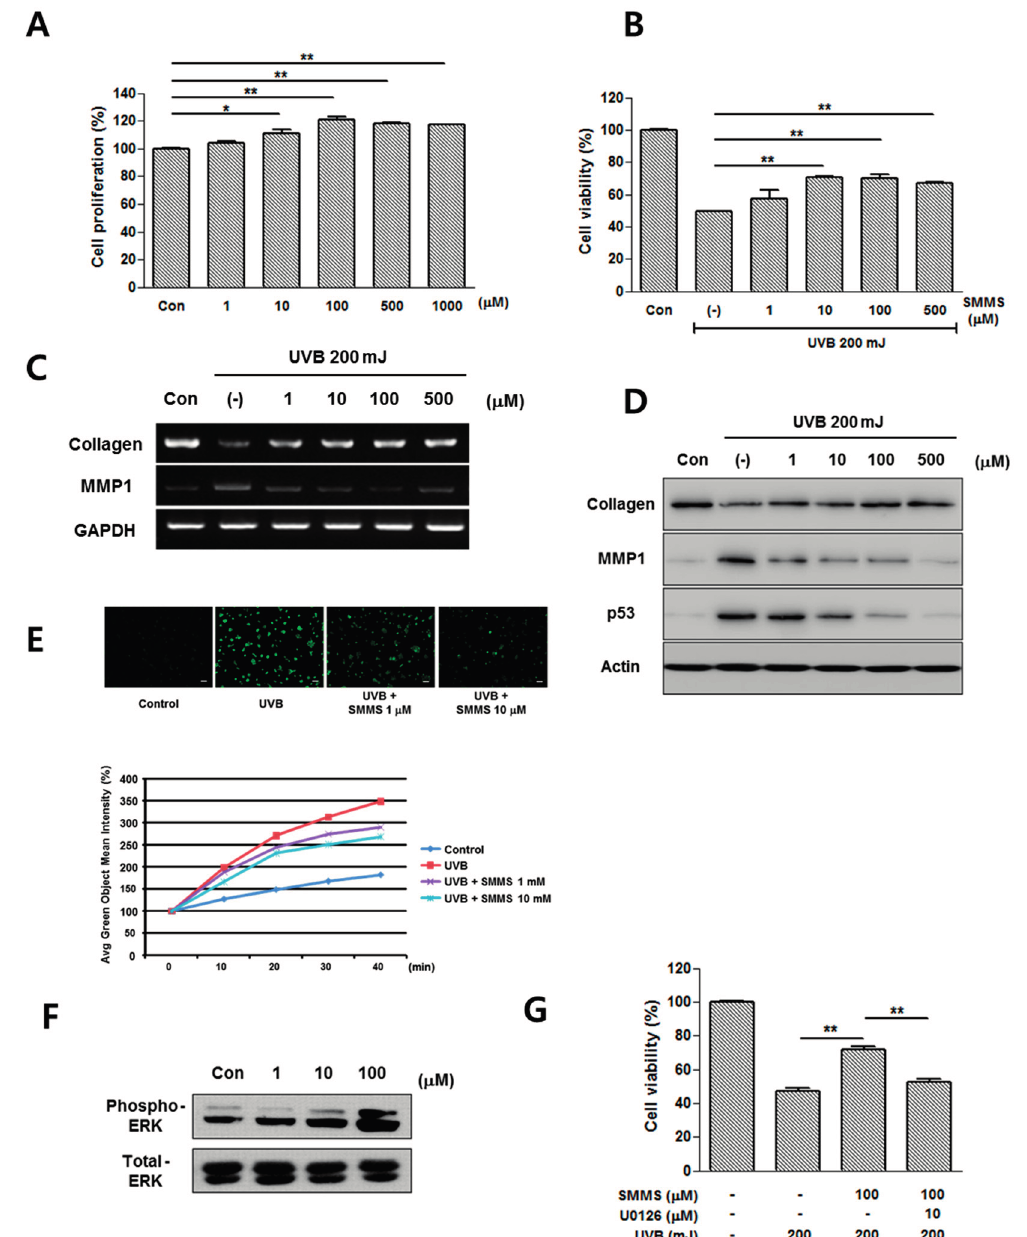
Figure 2. Photoprotective effects of SMMS in human dermal fibroblasts (hDFs). ( A ) SMMS increased the proliferation of hDFs. n = 3; ( B ) In addition, cell viability of hDFs was measured in the presence of 200 mJ UVB using MTT assay, and SMMS significantly increased the survival of hDFs. Con stands for unirradiated control, (-) stands for UVB-irradiated control, n = 3; ( C ) The mRNA expression of type I collagen and matrix metalloproteinase 1 (MMP-1) in hDFs was measured by RT-PCR 24 h after SMMS treatment; ( D ) The protein levels of type I collagen, MMP-1, and p53 were detected by using Western blotting; ( E ) SMMS treatment (1 and 10 μ M) reduced the UVB-induced ROS generation in KPCs ( n = 1). Scale bars = 100 μ M; ( F ) SMMS significantly increased the levels of phosphorylated ERK1/2 in a dose-dependent manner; ( G ) Pharmacological inhibition of ERK1/2 (U0126) significantly inhibited the SMMS-induced survival of hDFs ( n = 3). * p < 0.05, ** p <